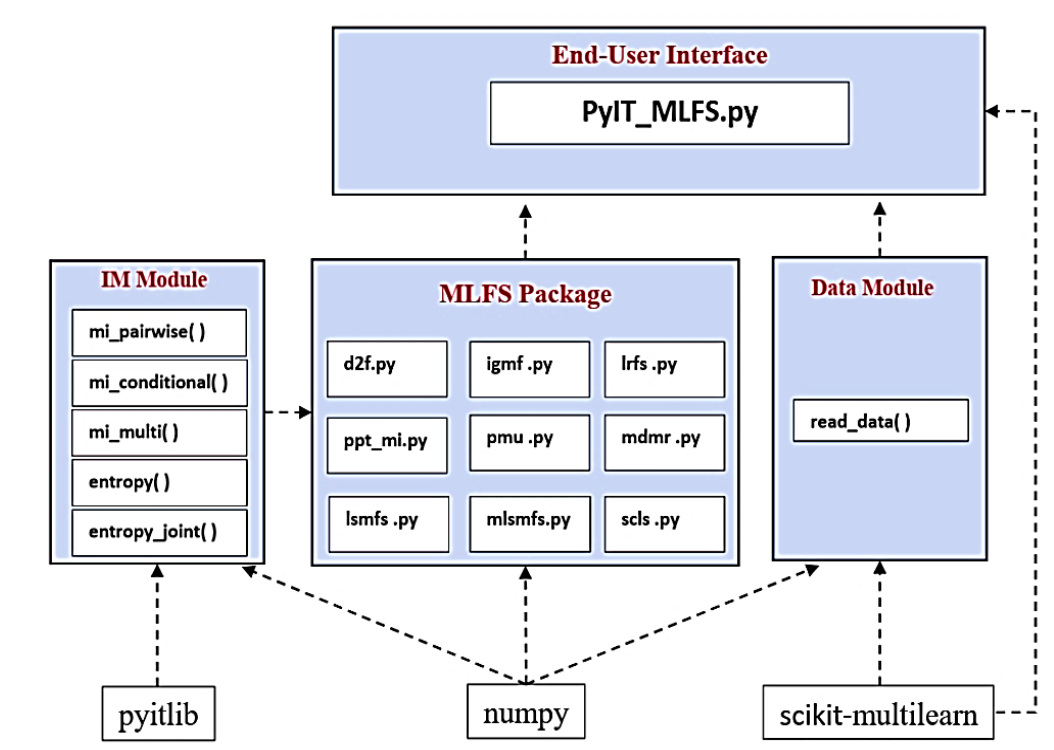
Fig. 1. Architecture of